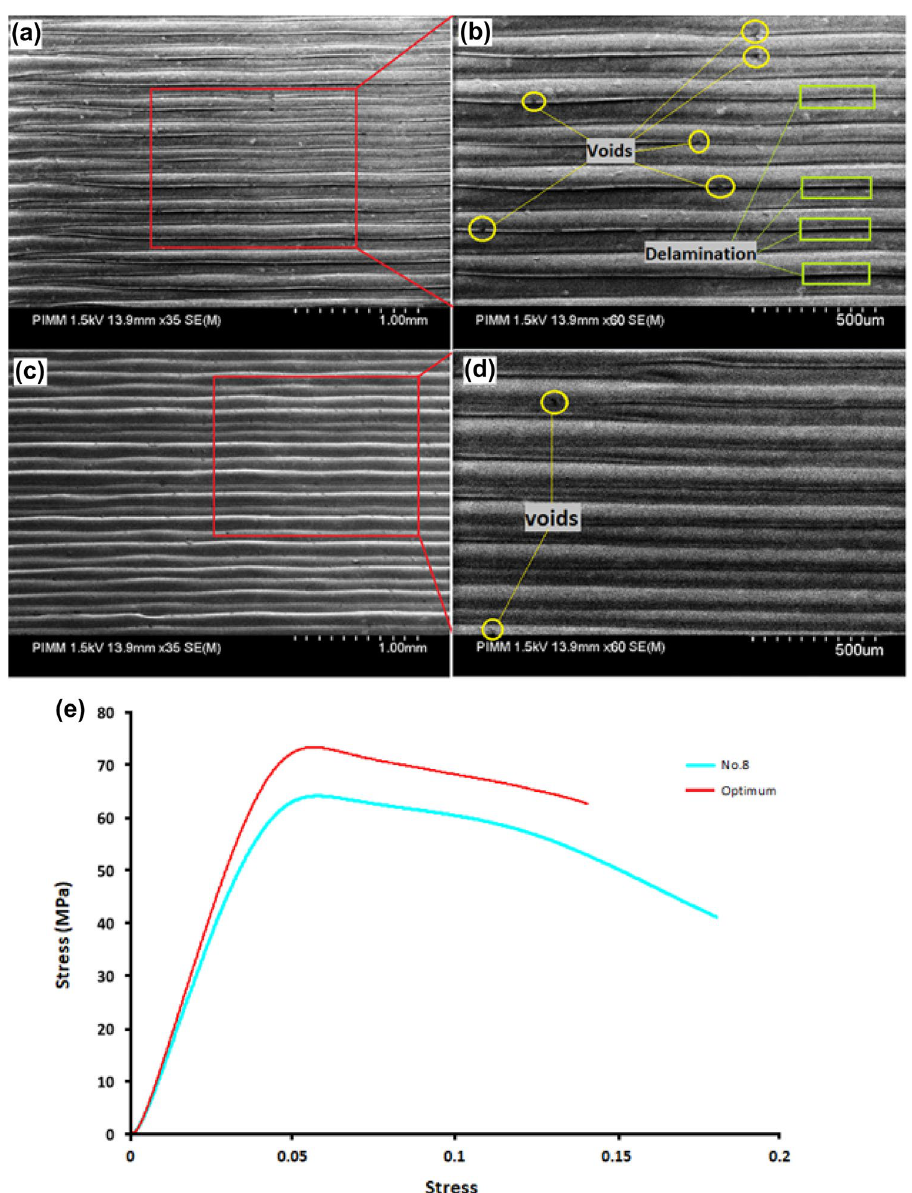
Figure 13. Scanning Electron Microscopy (SEM) images of the samples manufactured by FFF in ( a , b ) 8th, ( c , d ) and optimum condition, respectively. ( e ) Stress strain curve of initial GRG (8th) and the GRG obtained from the experiment.